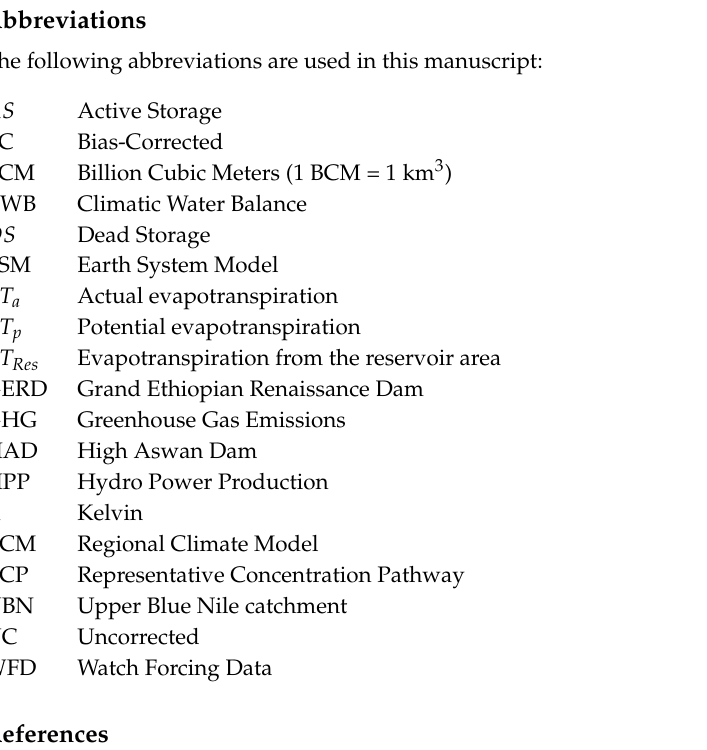
and temperature changes in the UBN projected by the climate model ensemble, Figure S1: GERD rule curves of the different operation scenarios, Figure S2: SWIM model performance in the 1960s and 1970s at gauge El Diem, Figure S3: Reservoir filling, inflows, and HPP simulated with climate model input in the reference period and operation scenario hpp 1500MW 01a (low seepage rate), Figure S4: Precipitation changes projected by the model ensemble, Figure S5: Temperature changes projected by the model ensemble, Figure S6: Operation scenarios under climate change projections and operation scenario hpp 1500MW 01a (low seepage rate), Figure S7: Sorted annual HPP in TWh − a of the three 30-years periods and operation scenario hpp 1500MW 01a (low seepage rate), in brackets the mean annual production and in square brackets the change